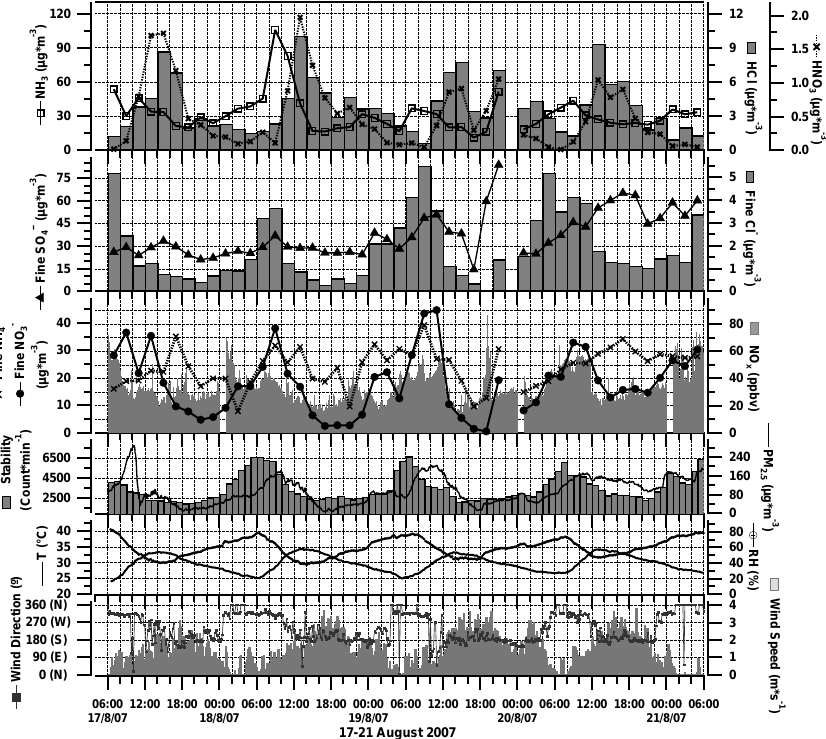
Fig. 9. Diurnal trends of fine particulate Cl − , NO − humidity (RH), wind speed and direction, and natural radioactivity (Stability) during the intensive summer measurements, carried out on a 24-h basis, at